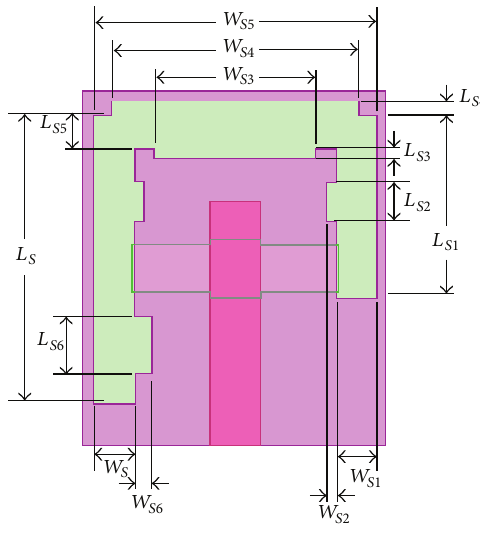
Figure1:Geometryoftheproposedaperturecoupledpatchantenna with inverted